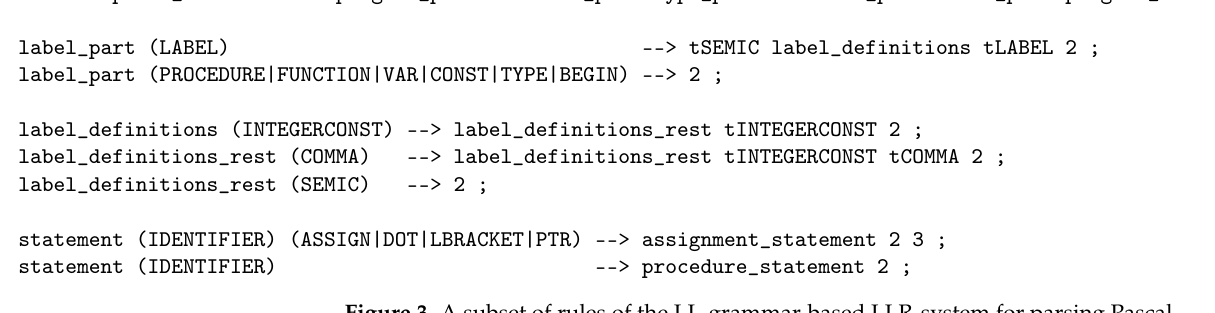
Figure 3. A subset of rules of the LL-grammar-based LLR-system for parsing Pascal. The other LLR-system has been made from scratch and is found to be more efficient (the same pattern as with the arithmetic expressions). A small subset of its 209 rules is